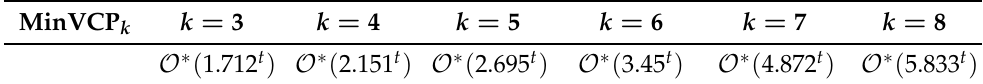
Table 2. The running times of MinVCP k for 3 ≤ k ≤